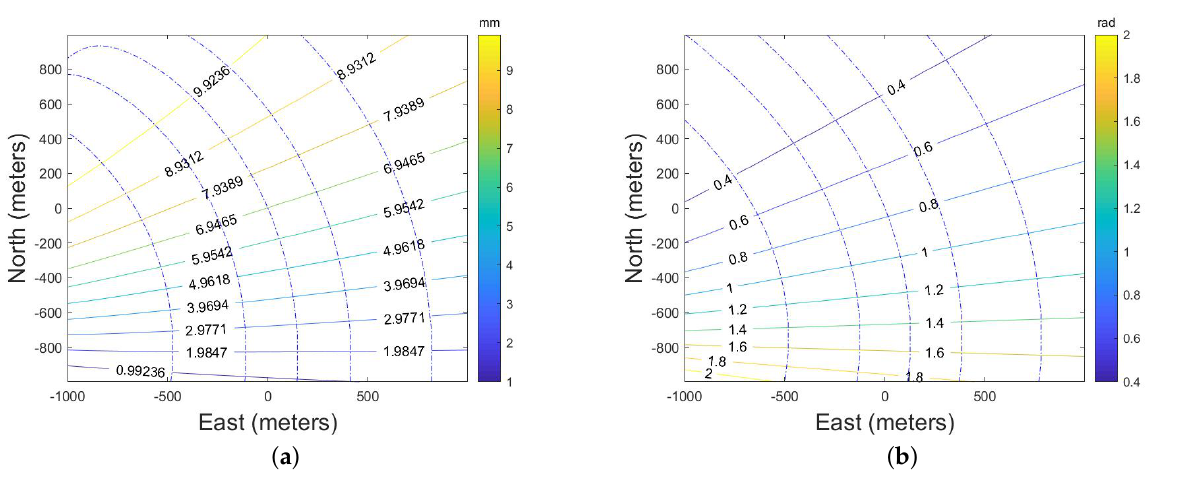
Figure 15. The bistatic spatial variance of the amplitude and initial phase under the BiSAR experiment. ( a ) is the result of amplitude. ( b ) is the result of the initial phase. The contour lines are shown as solid lines with values attached and the gradient lines are shown as blue dotted